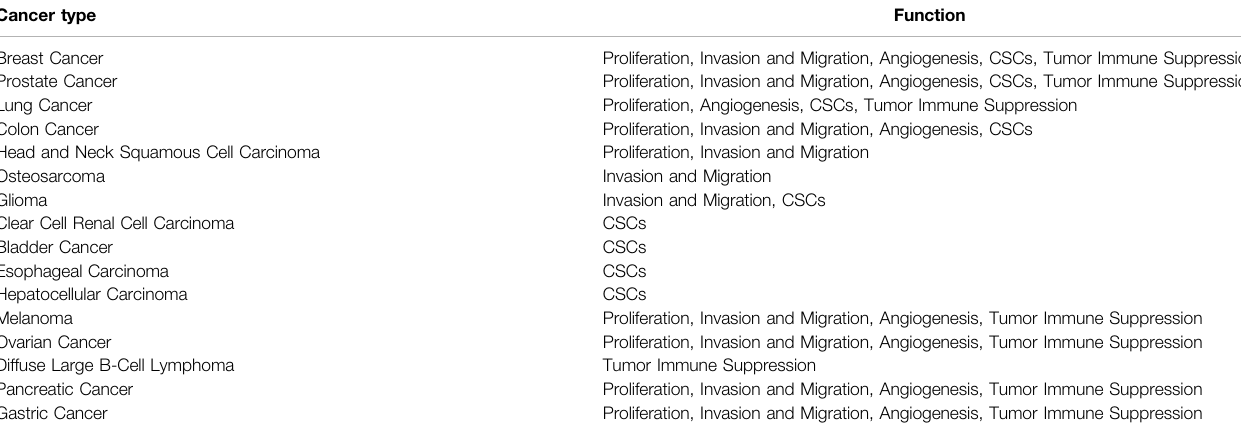
TABLE 1 | The role of CXCL8 in common cancers. CSCs=Cancer Stem Cells Cancer type Breast